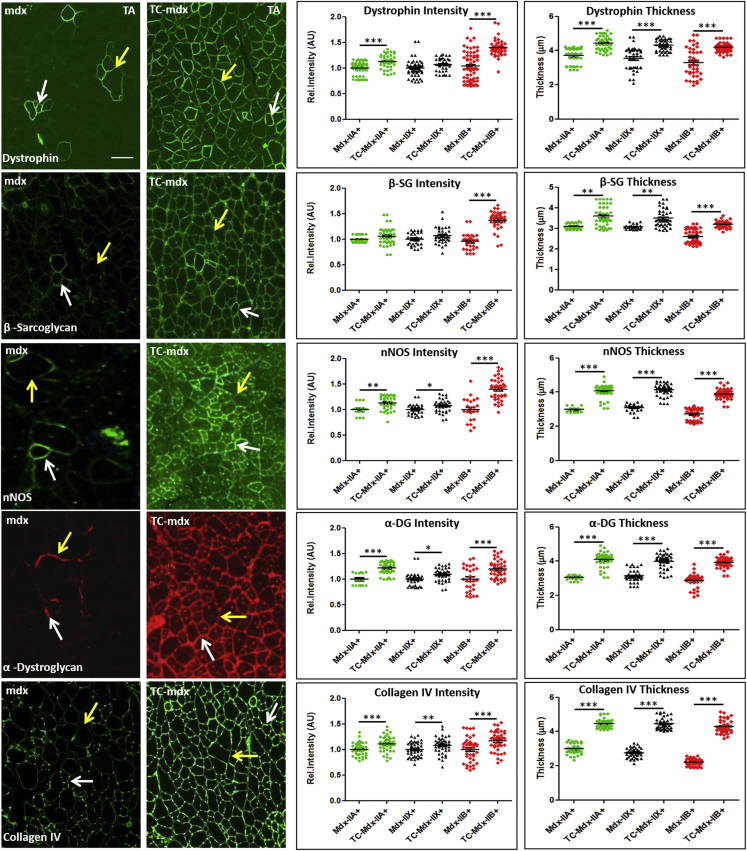
Semiquantitative Analysis of DAPC Restoration following tc-DNA Treatment of 20- to 22-Week-Old Male mdx MiceUntreated and tc-DNA-treated muscle shows high levels of individual proteins in MHCIIA fibers (white arrows) compared to MHCIIB fibers (yellow arrows). Intensities from over 30 regions for each fiber type were taken from revertant untreated mdx and set to a reference value of one. Similar numbers of intensity readings were plotted for each fiber type from tc-DNA-treated mdx muscle. In all cases there was a significant increase in intensity compared to untreated revertant fibers of the same MHC type. Thickness of expression domain was measured and plotted for each MHC isoform originating from revertant untreated mdx and tc-DNA-treated mdx muscle. MHCIIA fibers had thicker expression domains compared to MHCIIB. Thickness for expression domains irrespective of MHC fiber type was increased by tc-DNA treatment (n = 4 for each cohort). Scale bar applicable to all images represents 50 μm. *p < 0.05, **p < 0.01, and ***p < 0.001. Statistical analysis was performed using two-tailed t test.